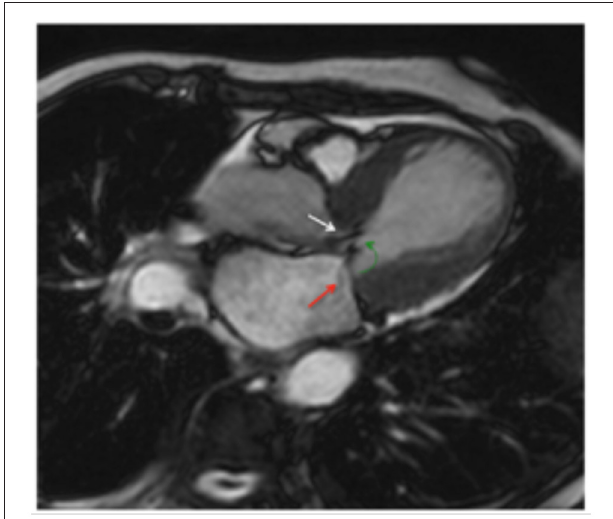
FIGURE 5 | Cine CMR horizontal long-axis view illustrating the systolic “jet” seen in LVOT (white arrow) with concurrent systolic anterior motion of the mitral leaflets (green arrow) and functional mitral regurgitation (red arrow). Adapted from Figure 6 in Plácido et al.